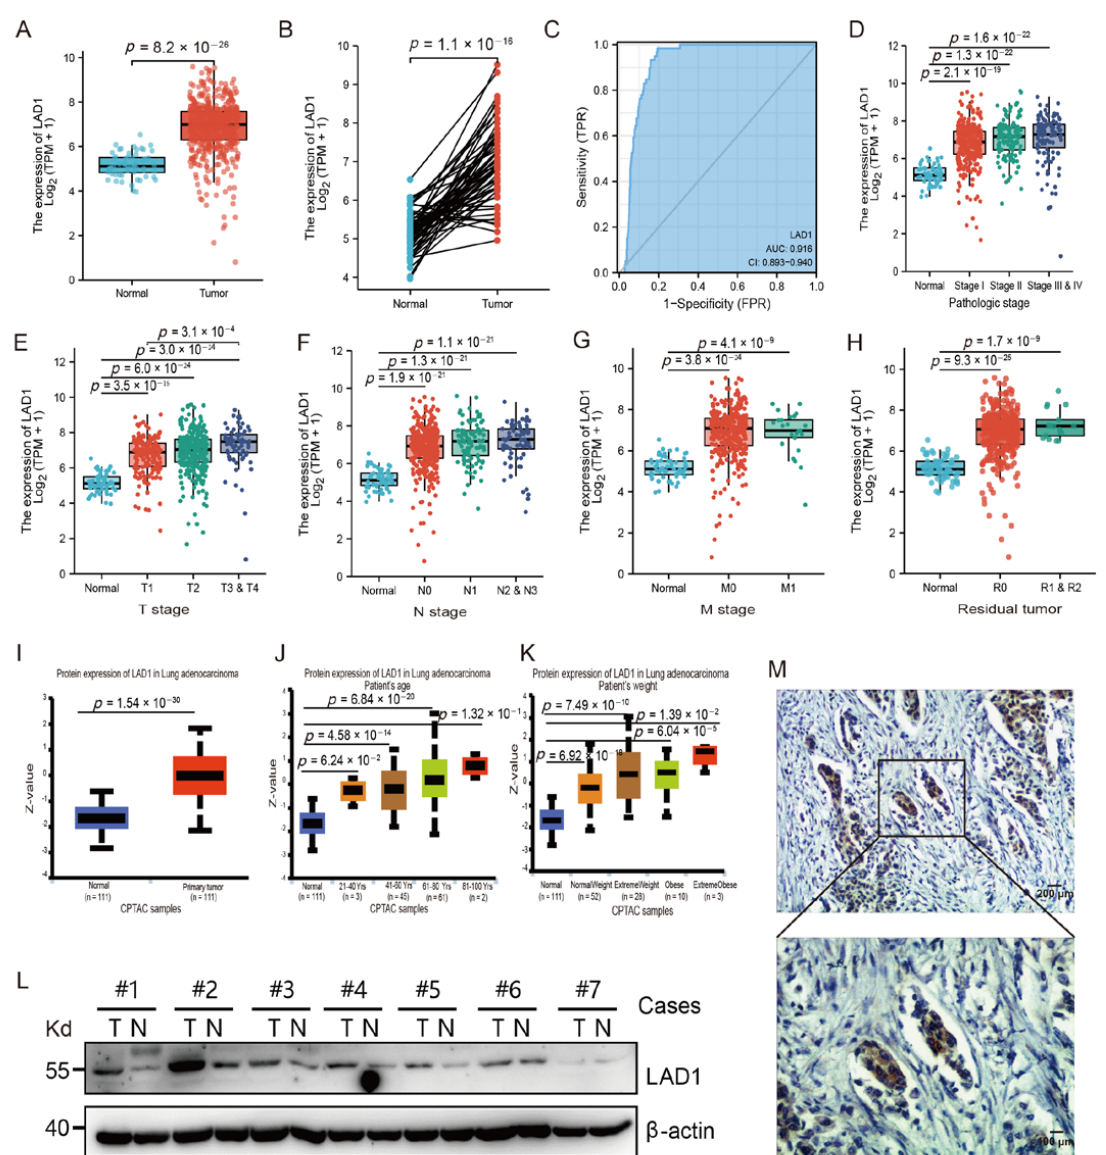
Figure 1. The upregulation of LAD1 expression in LUAD patients. ( A ) Comparison of LAD1 mRNA expression between 535 LUAD and 59 normal cases. ( B ) Comparison of LAD1 mRNA expression between 57 LUAD and matched normal tissues. ( C ) ROC analysis demonstrated the ability to differentiate tumors from normal tissues based on LAD1 expression level. ( D – H ) LAD1 expression in different groups of clinicopathological features, including pathologic stage ( D ), T/N/M stage ( E – G ), and residual tumor after chemotherapy ( H ). ( I – K ) LAD1 protein levels were elevated in LUAD patients and positively correlated with age and body weight. ( L ) The protein expression of LAD1 was examined by WB in 7 pairs of LUAD patients. #, Sample No. ( M ) Examination of LAD1 in LUAD tissues by